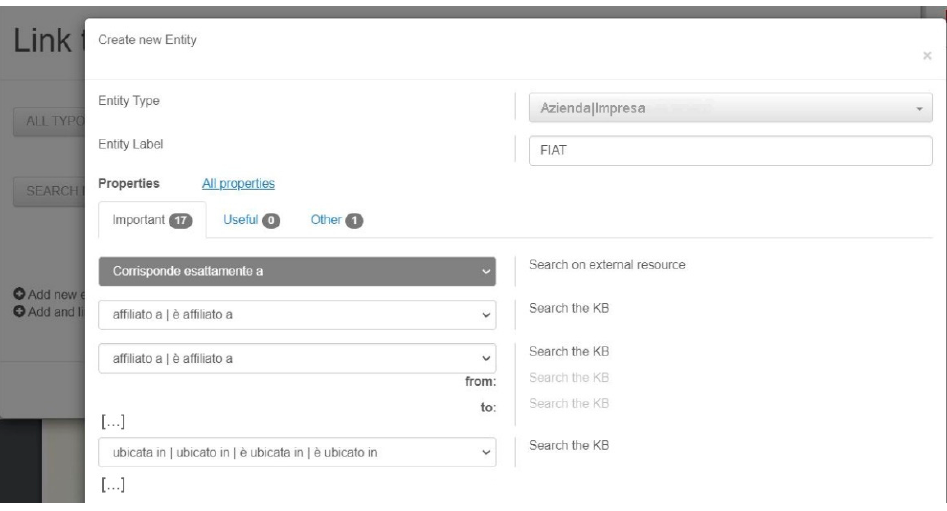
Figure 3. The modal window enabling users to select or add an entity.